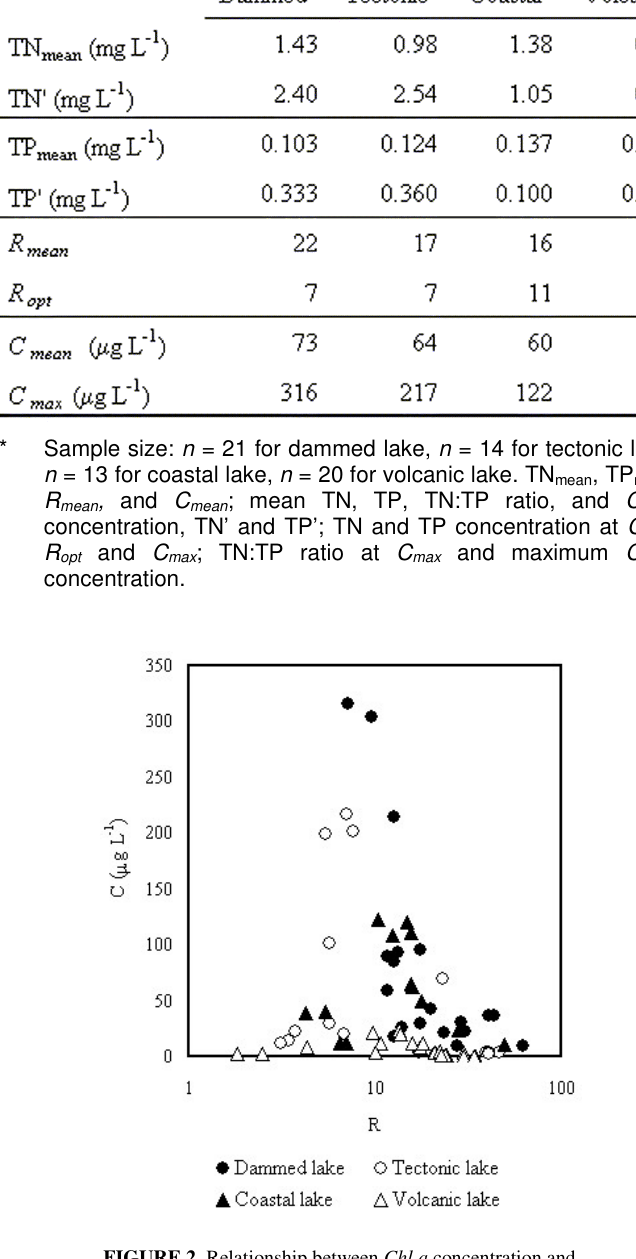
FIGURE 2. Relationship between Chl.a concentration and TN:TP ratio in the lakes used in this